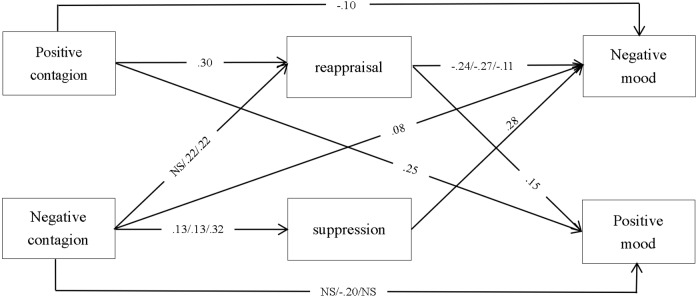
Ethnic differences in emotion processes including emotional contagion, emotion regulation, and mood state. The results shown refer to those from our restricted model (standardized estimates). When two coefficients are presented, the upper coefficient represents estimates of our ethnic Han participants, the middle coefficient represents estimates of our ethnic Dai participants, and the lower coefficient represents estimates of our ethnic Jingpo participants. All of the reported coefficients were significant at P < 0.05. NS, not significant.